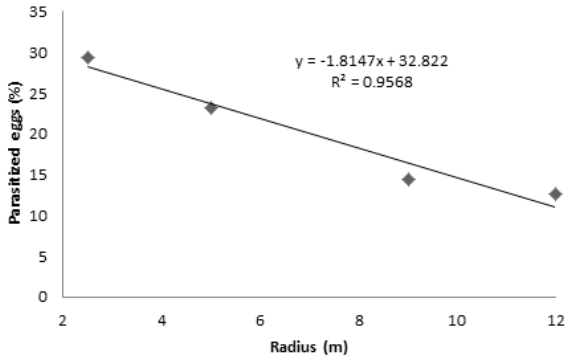
Figure 2. Scattering radius of Trichogramma pretiosum (Hymenoptera: Trichogrammatidae) and parasitism on eggs of the alternative host Anagasta kuehniella (Lepidoptera: Pyralidae) in maize V8 stage (F= 10.14 e P= 0.0861).